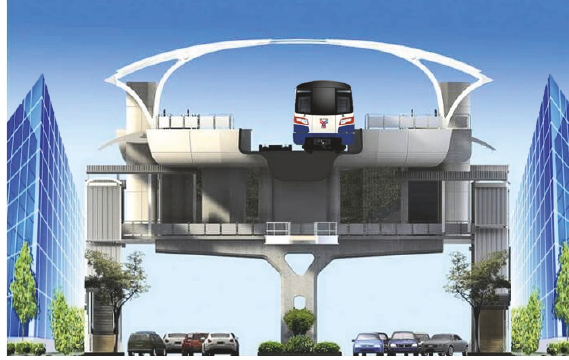
Figure 1: The street tunnel